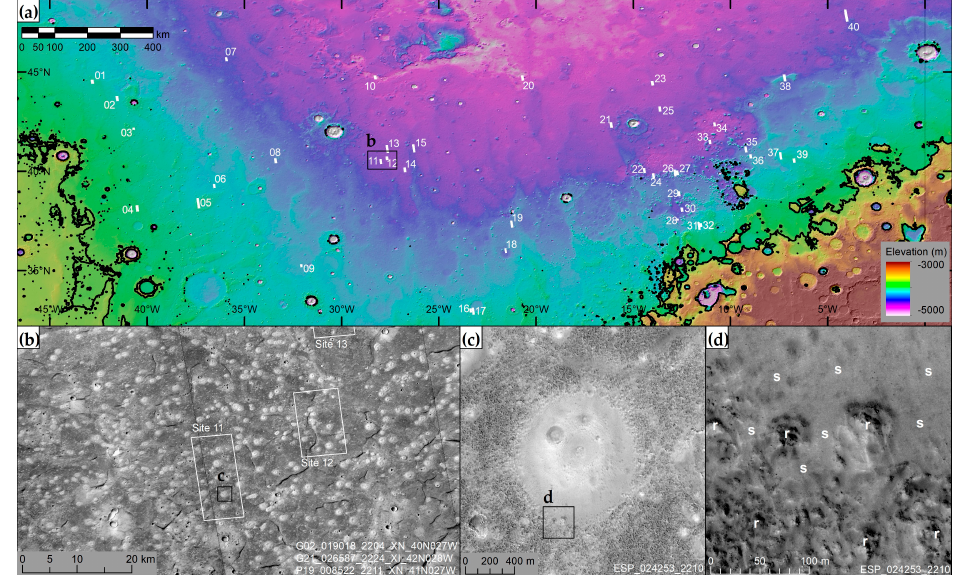
Figure 2. ( a ) MOLA gridded elevation overlain on MOLA hillshade background (128 pixels per degree) of northern Chryse–southern Acidalia region. The black lines are a − 3760 m-contour approximating the Deuteronilus shoreline [2,11]. White-filled numbered rectangles represent the locations of digital elevation models (DEMs) generated in this study (Site 01 to 40, listed in Table 1). ( b ) Part of a mosaic of Mars Reconnaissance Orbiter (MRO) Context Camera (CTX) images [53], showing the central part of southern Acidalia Planitia. Pitted mounds appear as bright, circular features on the polygonally fractured terrain [17]. Sunlight illuminates the scene from the left. ( c ) A typical example of a pitted mound. Part of High Resolution Imaging Science Experiment (HiRISE) image ESP_024253_2210. Image credit: NASA/JPL/UA (University of Arizona). North is at the top. ( d ) Close-up view of the boundary between the mound and the surrounding plains in Figure 2c. Smooth mound materials (labeled as ‘s’) appear to overlie the surrounding terrain with relatively rough surfaces (labeled as ‘r’).